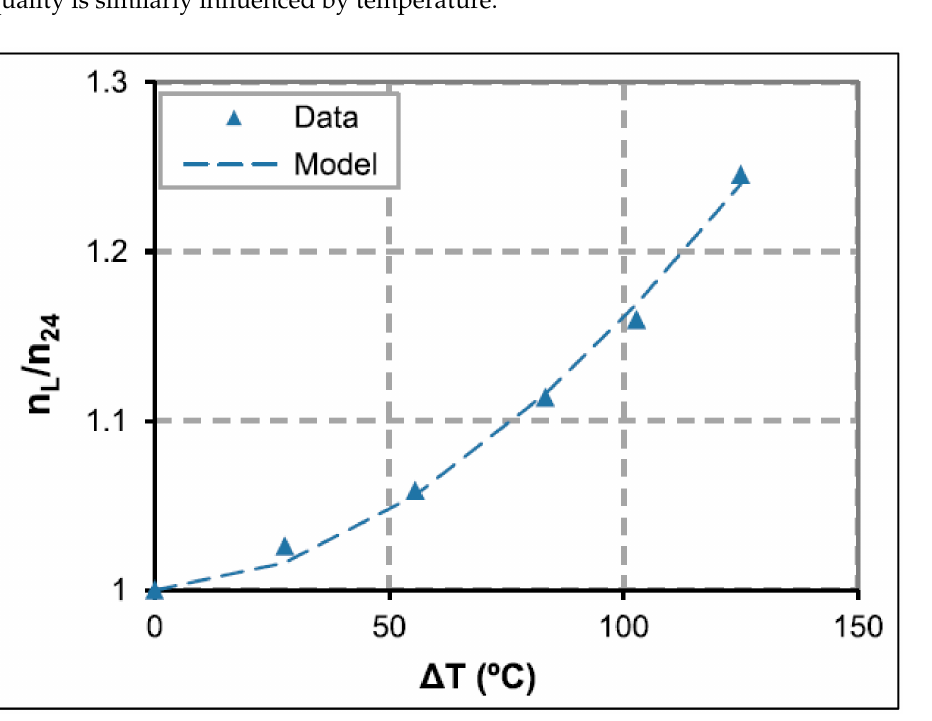
Figure 10. Fluid flow behaviour against temperature (Reprinted with the permission from Sinha et al. [51]). Copyright 2019, Elsevier